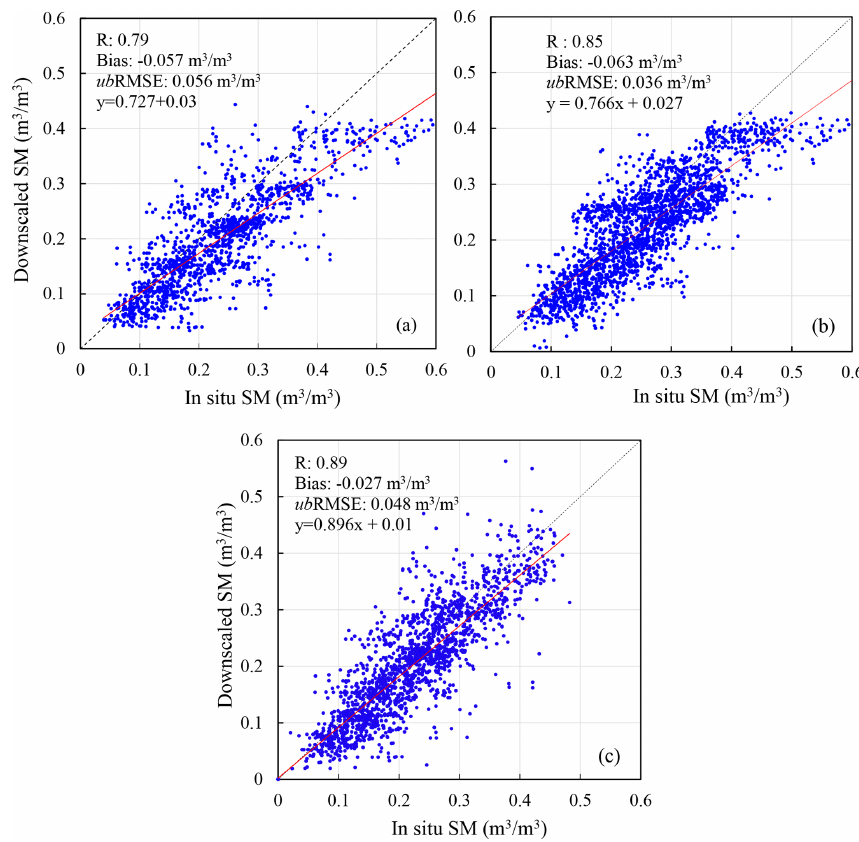
Figure 3. Correlations between the downscaled SM and in situ SM measurements at the (a) monthly, (b) seasonal and (c) annual scales. The solid lines are the trend lines, and the dashed lines are the y = x reference